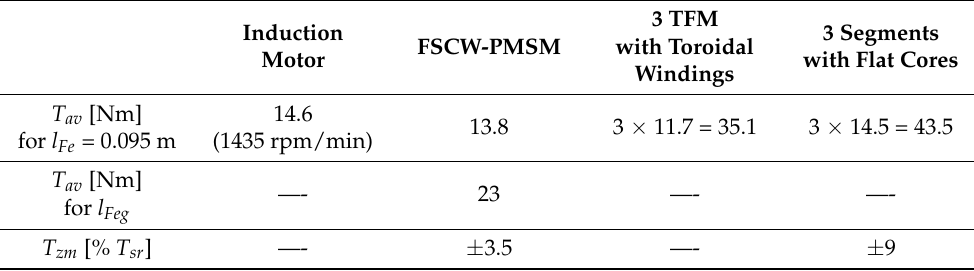
Table 1. Summary of the torque generated by individual